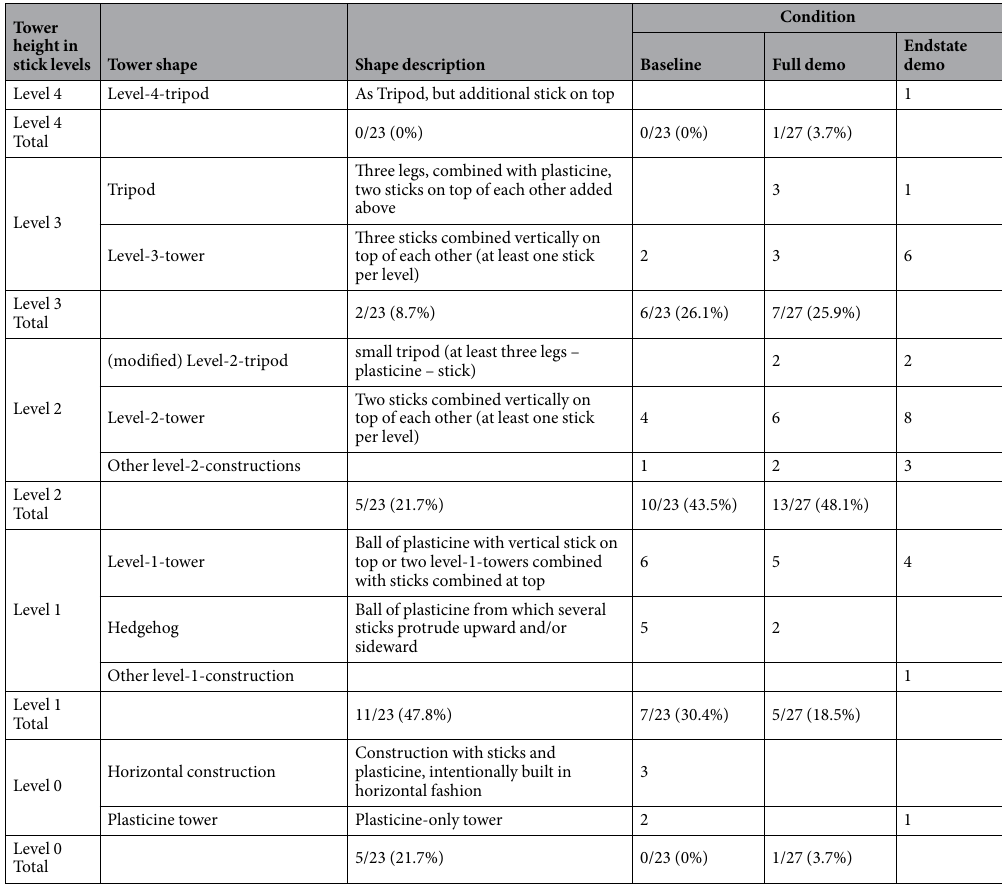
Table 1. Distribution of tower height in stick levels and tower shape in the three